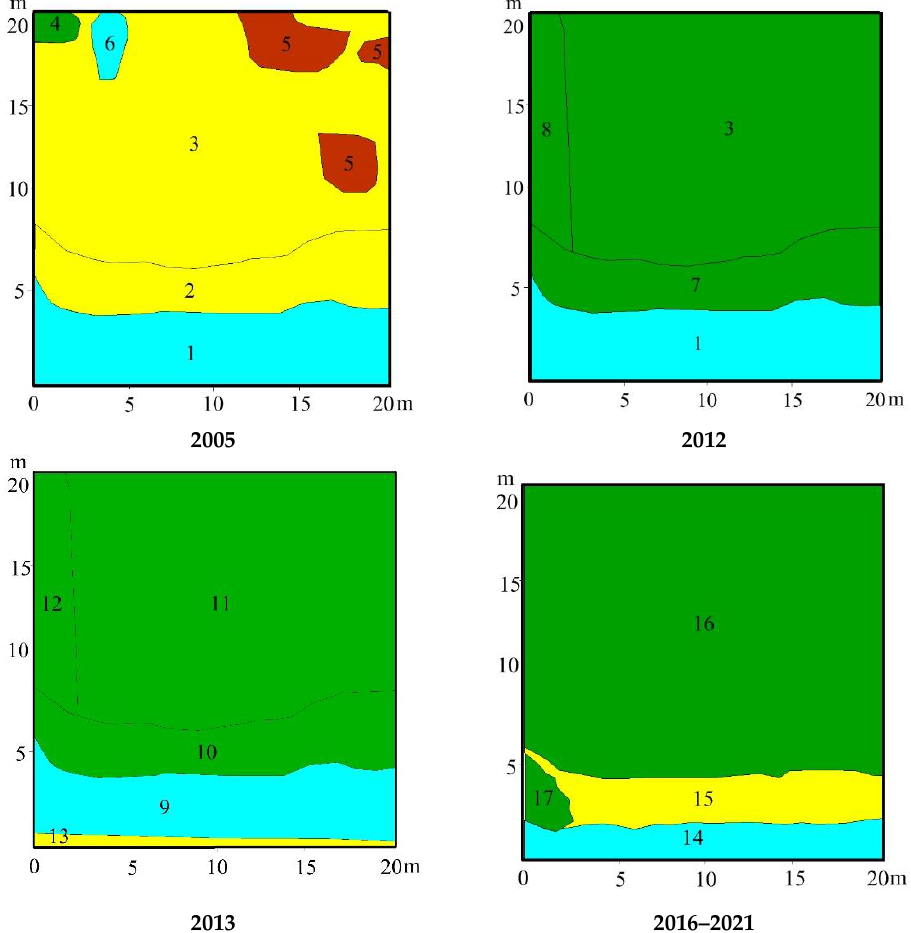
Figure 13. Changes in vegetation on permanent plot No. 10: 1 Carex rostrata + Juncus filiformis ; 2